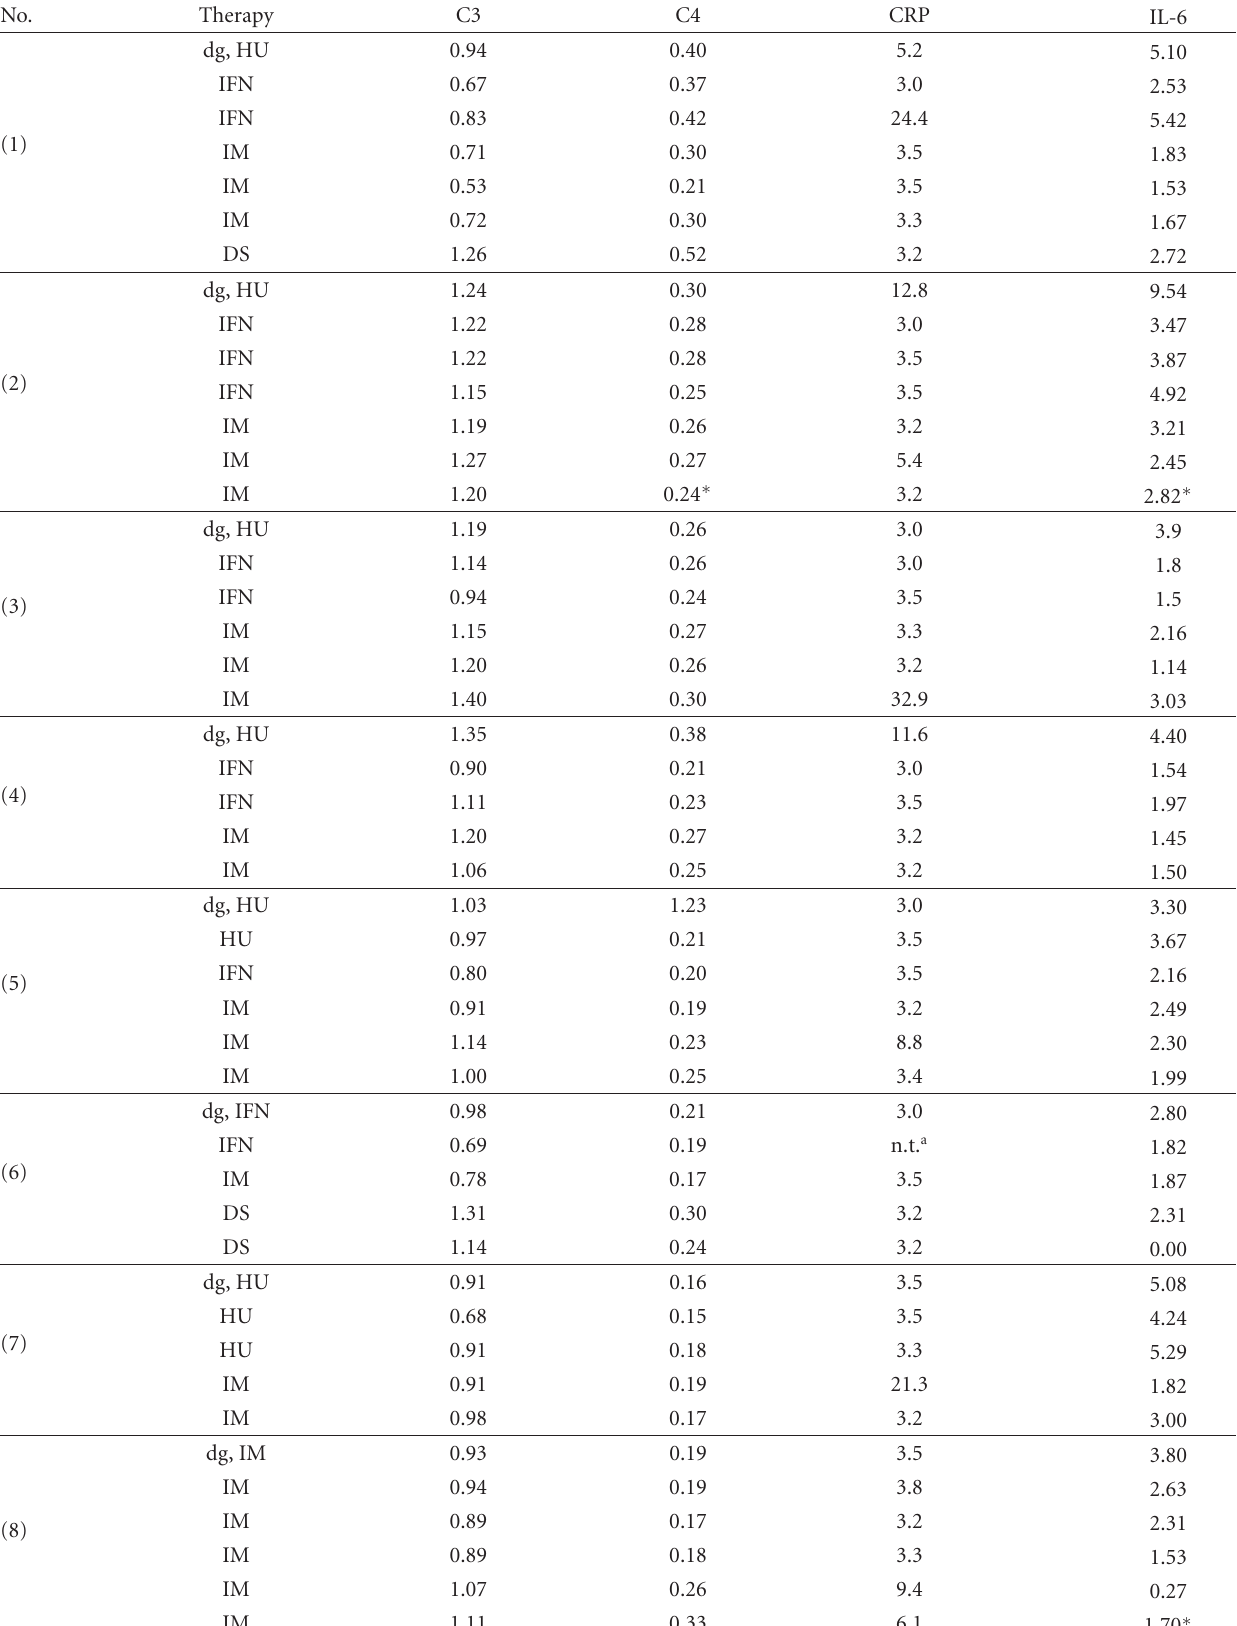
Table 4: Complement components, CRP and